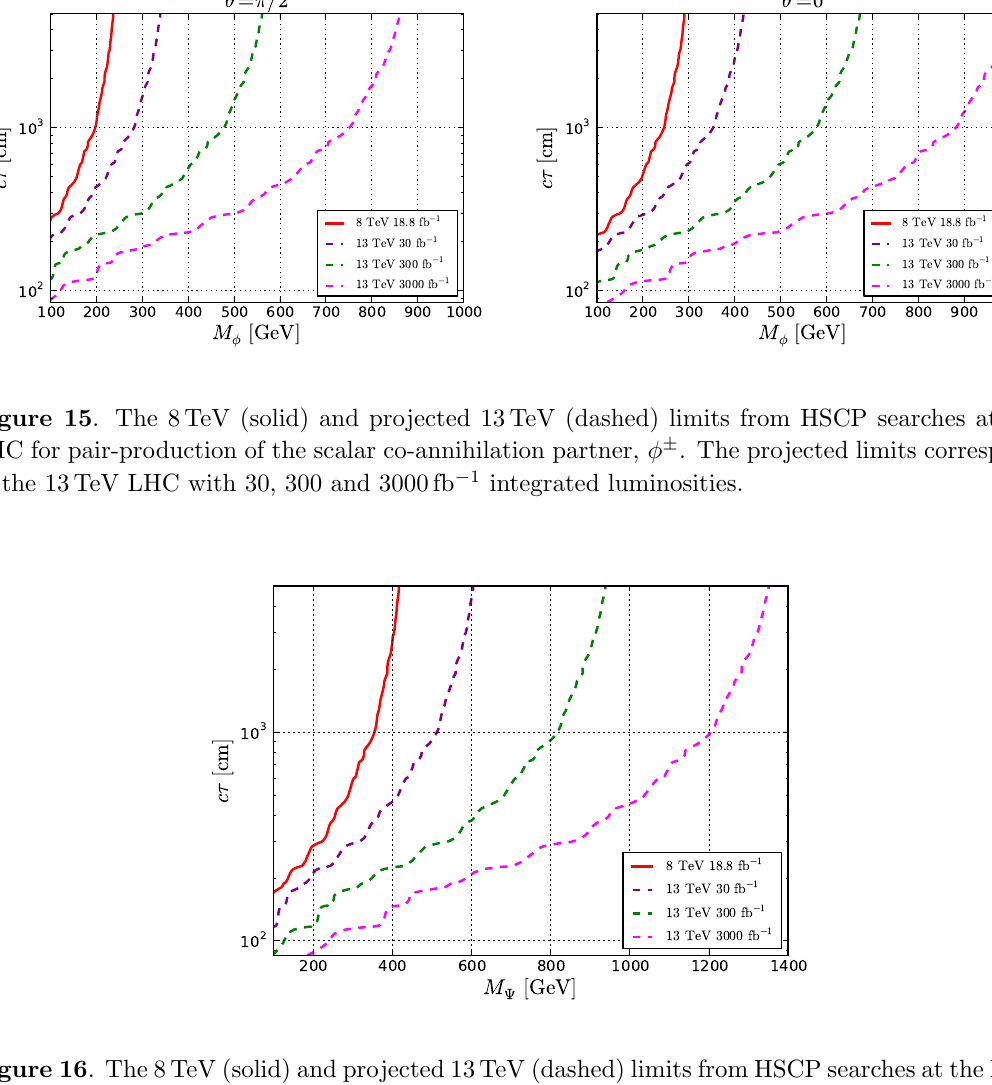
on the mass vs lifetime plane. The plots in (cid:12)gure 15 shows the 8 TeV (solid) and projected (dashed) limits for the pair-production of long-lived complex scalar (cid:12)eld, (cid:30) , as a function of the mass, M (cid:30) , and the lifetime times the speed of light, c(cid:28) . The left plot assumes (cid:30) has the same quantum number as the right-handed (cid:28) corresponding to Simpli(cid:12)ed Model 1a. In the right plot, on the other hand, the interaction of (cid:30) is obtained by the procedure explained in section 5.2 (Simpli(cid:12)ed Model 1b) and taking (cid:18) = 0. The co-annihilation partner (cid:30)